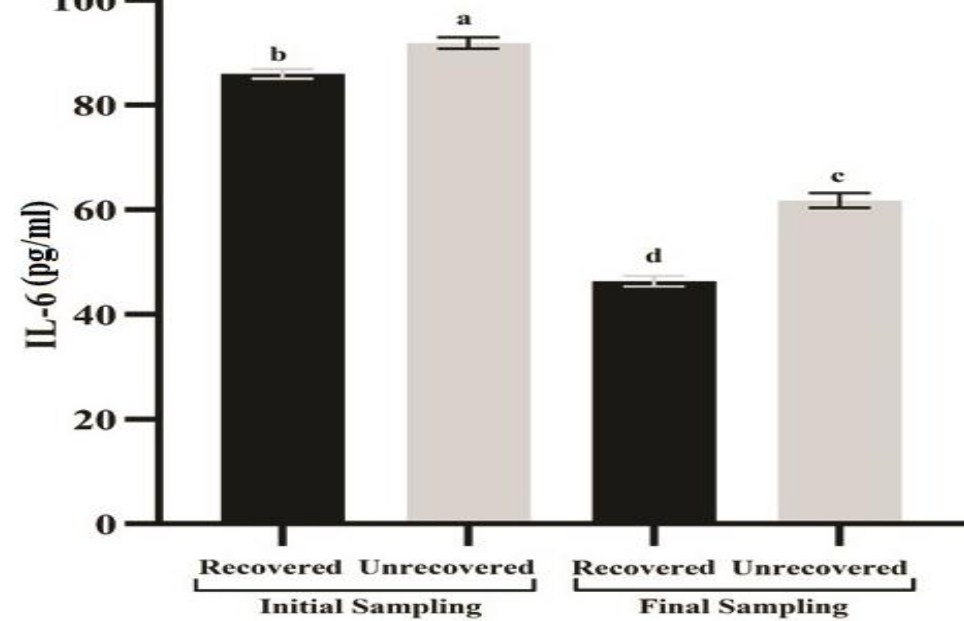
Figure 2. Comparison of serum IL-6 concentration in LSDV infected cattle. Means (±SEM) without a common superscript letter differ significantly ( p < 0.05). The infected cattle were grouped by recovery at 17 days after baseline sampling. The serum IL-6 concentrations of the recovered group ( n = 33) and the unrecovered group ( n = 17) were analyzed by two-way ANOVA and the Tukey test. The ROC analysis for serum IL-6 concentration of the LSDV-infected cattle at the baseline sampling showed a cut-off value of 85.16 pg/mL at a sensitivity of 94% and specificity of 55% for recognizing the cattle with a continued disease duration. The AUC of 0.8039 (0.6834 to 0.9244: 95% CI, p = 0.0005) showed a good prognostic ability of serum IL-6 to differentiate between recoverable and unrecoverable animals at the initiation of LSDV infection (Figure